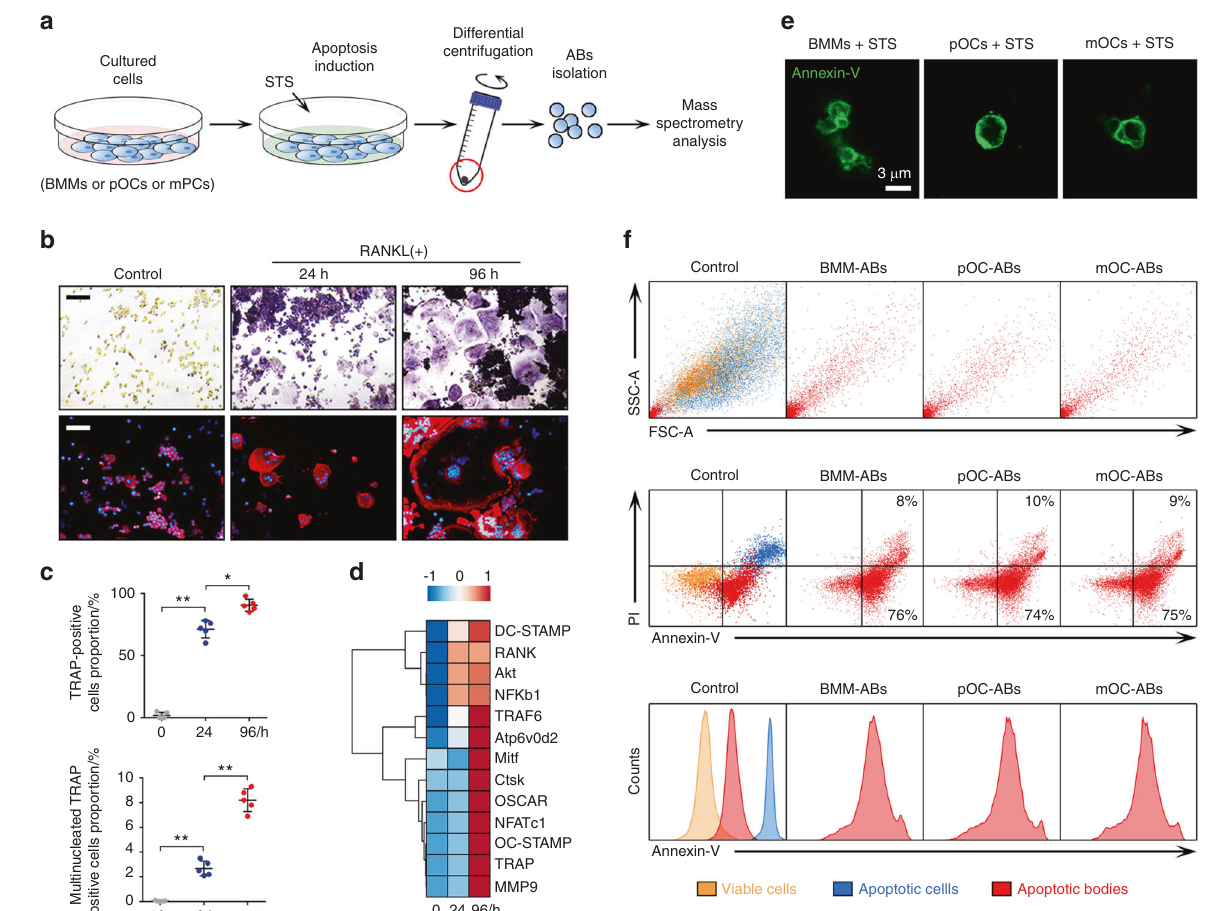
Fig. 1 Isolation and characterization of ABs from BMMs, pOCs, and mOCs. a Graphical illustration of the procedure for AB isolation. b Images of TRAP and IF staining of the cytoskeleton of BMMs, pOCs, and mOCs. Cell nuclei stained with DAPI are shown in blue, and vinculin is shown in red. The scale bars represent 200 μ m. c The proportions of TRAP-positive cells and multinucleated TRAP-positive cells were quanti fi ed in each well (96-well plate), n = 5. d Heat map showing the expression pro fi le of RANKL-dependent speci fi c osteoclastogenic genes from 0 h (BMMs) to 96 h (mOCs). e Representative images of ABs stained with Annexin-V/FITC. The bar represents 3 μ m. f FSC/SSC analysis and Annexin-V/PI analysis of viable cells, apoptotic cells, and ABs. The data in the fi gures are presented as the average ± SD values. Statistically signi fi cant differences between the treatment and control groups are indicated as * ( P < 0.05) or ** ( P < Here, we mapped the whole-proteome signatures in osteoclast- derived ABs. Through bioinformatic analysis, we showed marked protein cargo differences among different ABs and revealed the corresponding proteomic signatures. Comparison of the whole proteome of these cells with that of the respective parental cells revealed high signature similarity. This similarity was further con fi rmed at the functional level via in vitro and in vivo experiments.